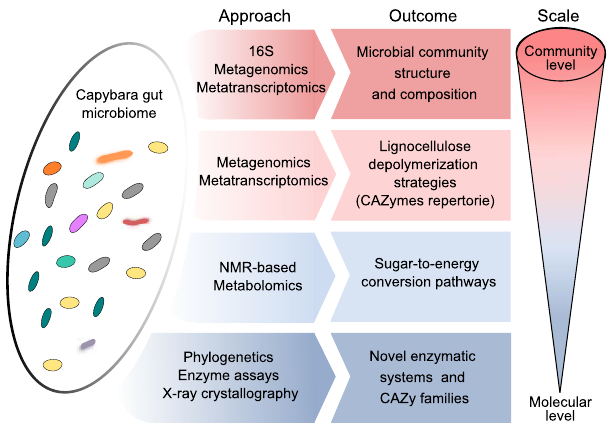
Fig. 1 Experimental design employed to explore capybara